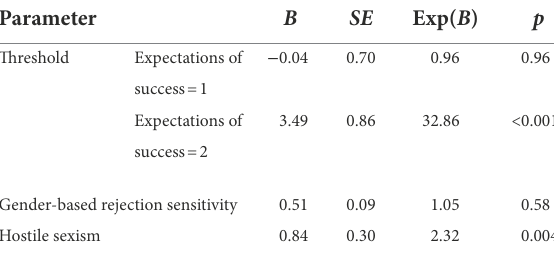
TABLE 2 Summary of OLR model on men’s gender-related relative expectations of